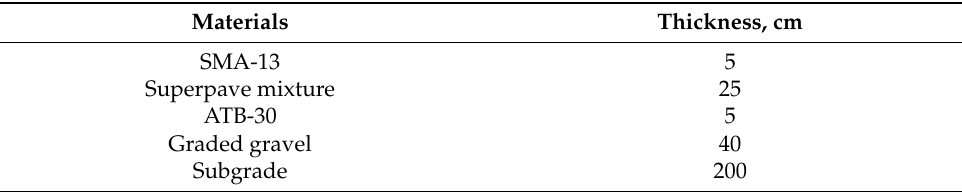
Table 5. The thickness of typical asphalt pavement